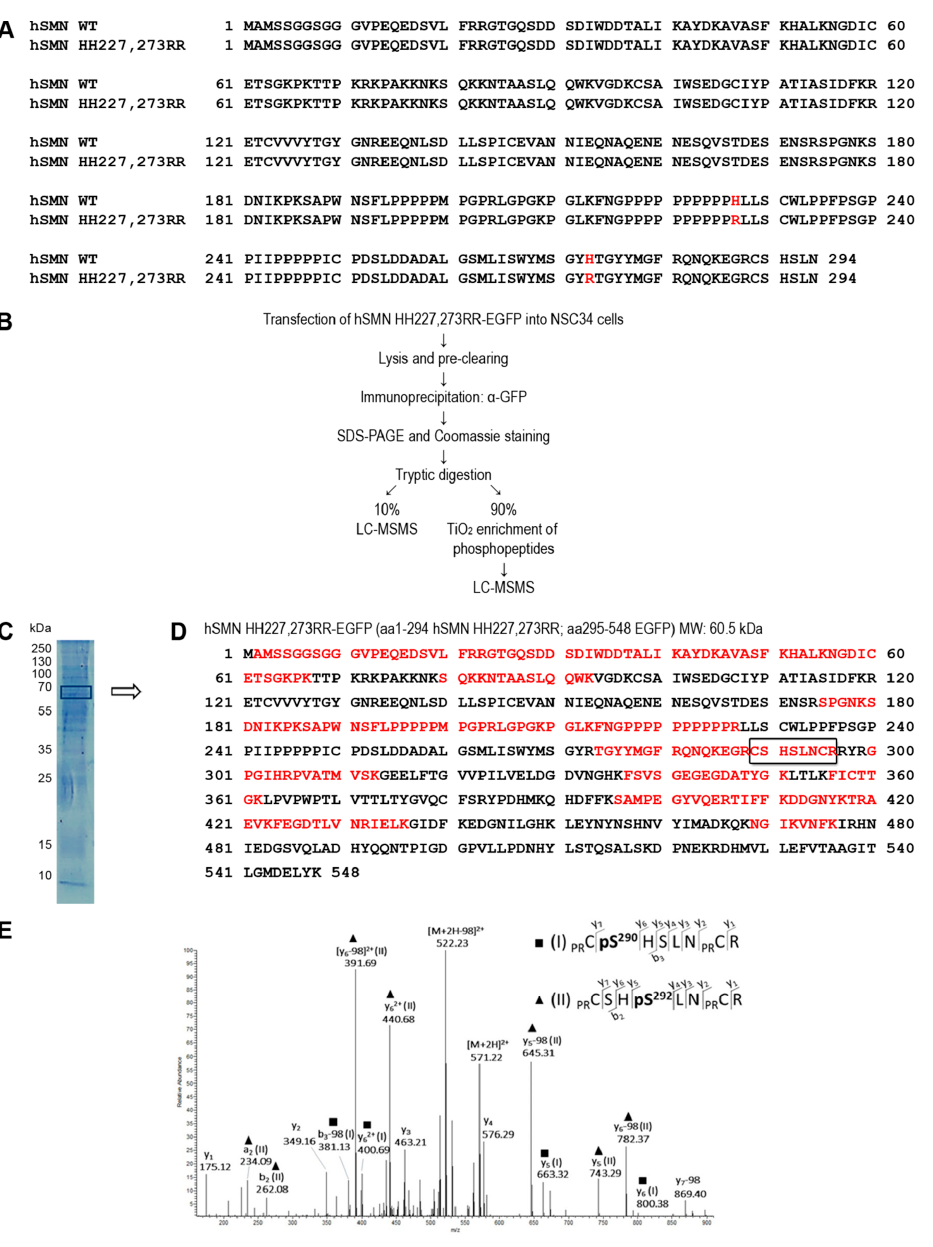
Figure 1. Phospho-analysis by mass spectrometry identifies human survival of motoneuron (hSMN) S290 and S292 as phosphorylation sites. ( A ) Sequence alignment of hSMN wildtype (WT) and mutant hSMN HH227, 273RR for trypsin cleavage at the C-terminus with the mutated site for additional